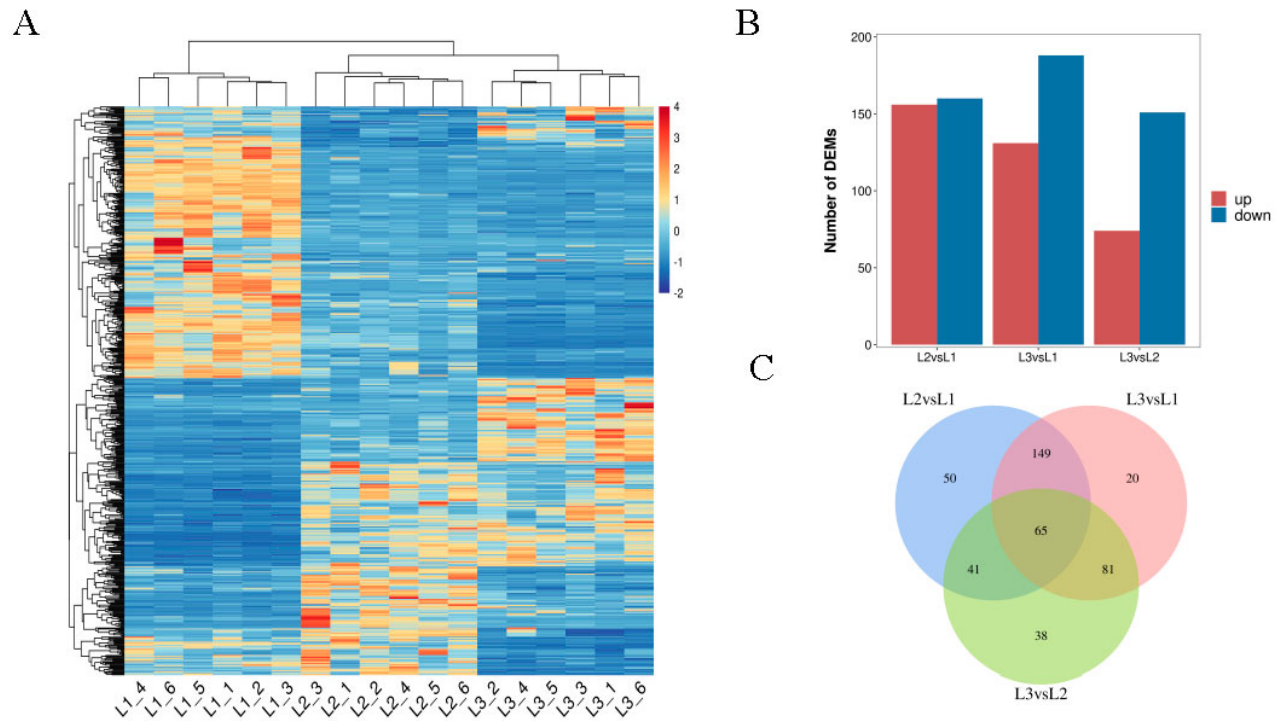
Figure 4. Characteristics and analysis of DEMs in walnut embryos at different developmental stages. ( A ) Heat map of DEMs based on the peak area. The color scale represents the calculated Z − score. The red blocks indicate upregulated metabolites; the blue blocks indicate downregulated metabo ‐ lites. ( B ) Number of DEMs in different combinations. The blue bar denotes downregulated metab ‐ olites; the red bar denotes upregulated metabolites. ( C ) Venn diagram of DEMs in different combi ‐ nations. L1 was 60 DAP, L2 was 90 DAP, and L3 was 120 DAP. (L2 − VS − L1, L3 − VS − L1, L3 − VS − L2; “a” was the experimental group; “b” was the control in “a − vs − b”).